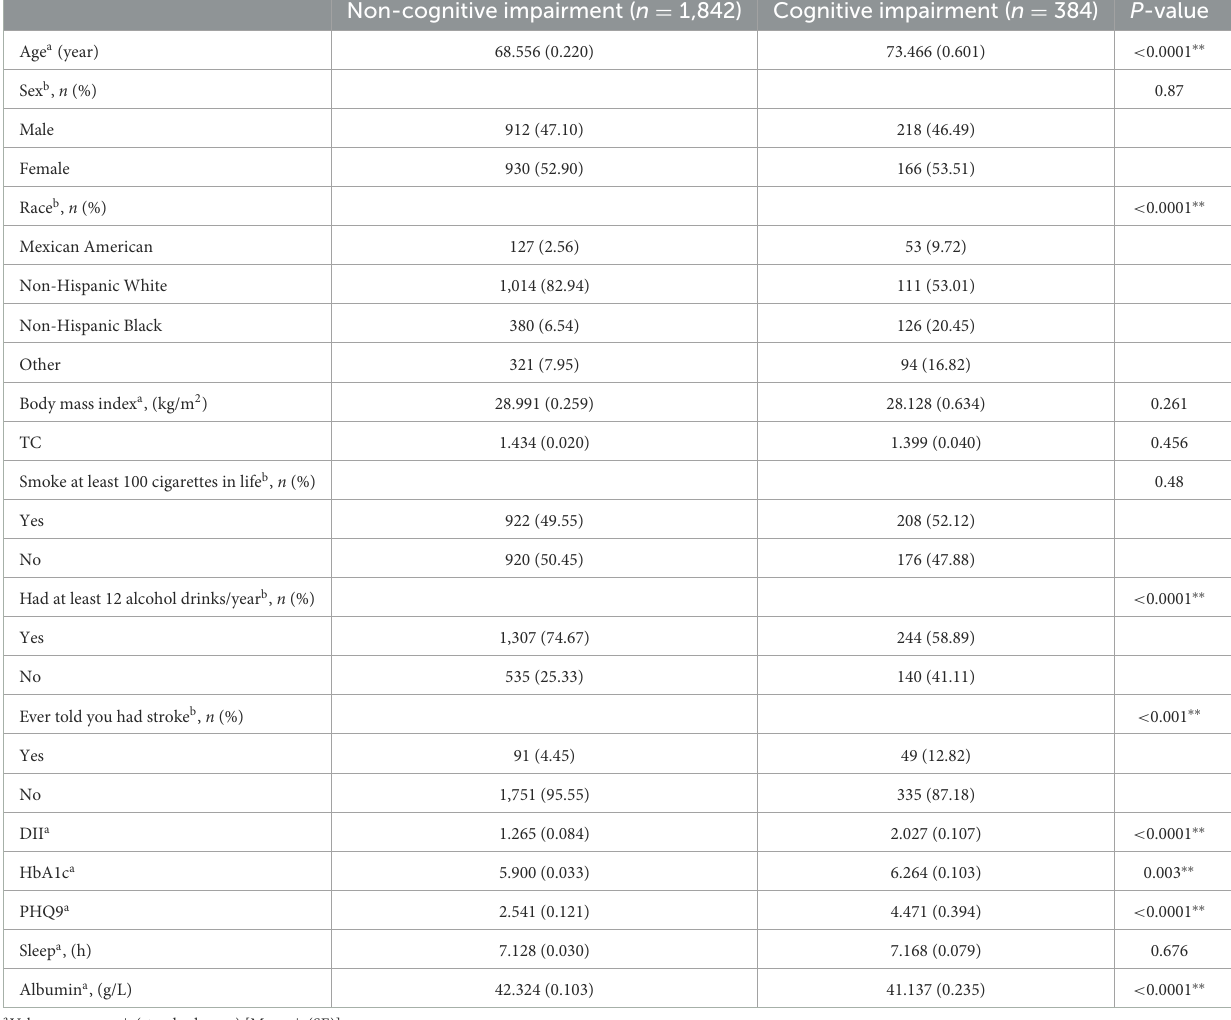
TABLE 1 Characteristics of